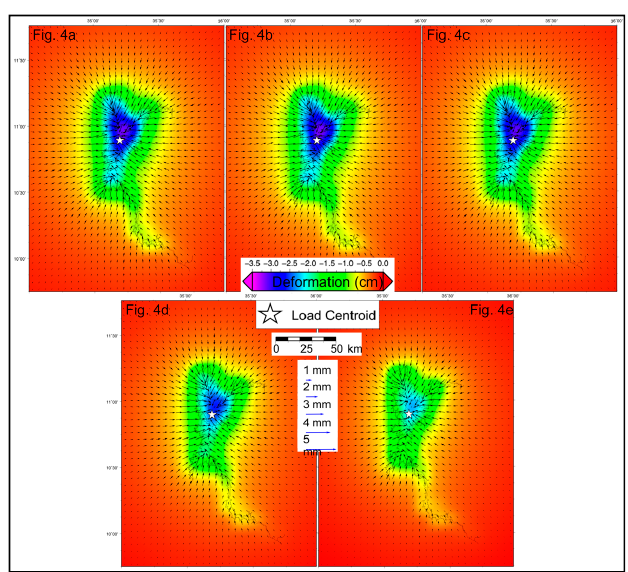
Figure 4. Vertical and horizontal displacements from each of the five average annual operational scenarios. The modeled vertical displacement is plotted on the colored grid while the horizontal displacement motion vectors are plotted on top. The maximum water level weighted hydrologic load centroids are plotted as stars. The maximum areal extent of the reservoir for each of these scenarios is drawn as a black polygon. ( a – e ) correspond to the average annual seasonal scenarios L1–L5, respectively. These are the maximum accumulated displacements for each of the five average annual operational scenarios.